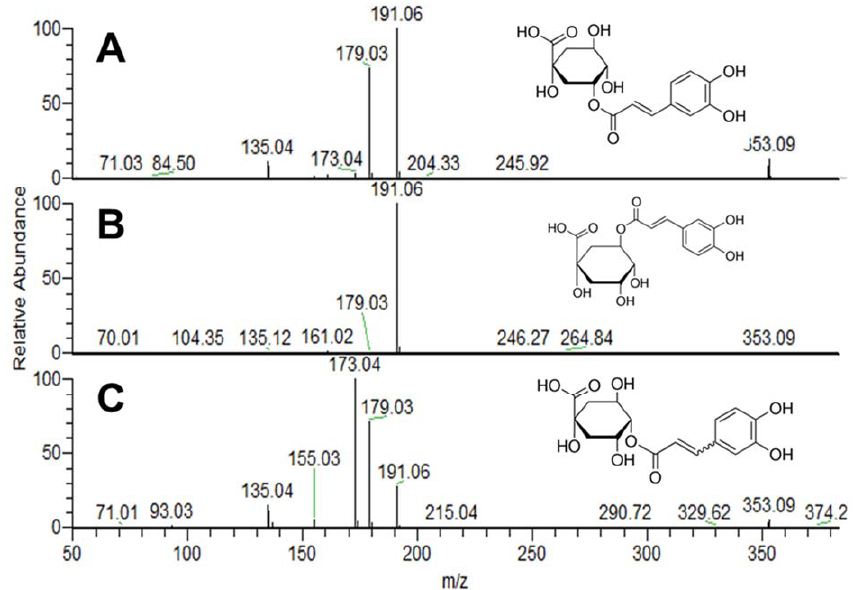
Figure 2. MS 2 of [M − H] − ions and chemical structures of neochlorogenic acid ( A ), chlorogenic acid ( B ) and cryptochlorogenic acid ( C ). The XO inhibitory activities of the three chlorogenic acid isomers at 1 mM were measured in vitro, and are shown in Figure 3. The results show that all the three chloro ‐ genic acid isomers exhibited XO inhibitory activities. The inhibitory activity of chloro ‐ genic acid was found to be slightly lower than that of neochlorogenic acid or crypto ‐ chlorogenic acid. No significant difference was detected between the inhibitory activity of neochlorogenic acid and that of cryptochlorogenic acid. Figure 3. XO inhibitory activities of neochlorogenic acid, chlorogenic acid and crypto ‐ chlorogenic acid. Data are presented as mean ± SEM ( n = 6).